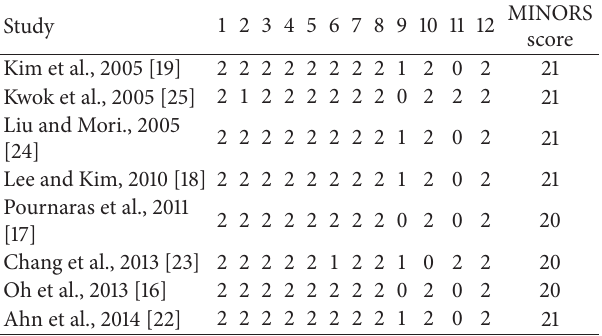
Table 1: Quality assessment using the Methodological Index for Nonrandomized